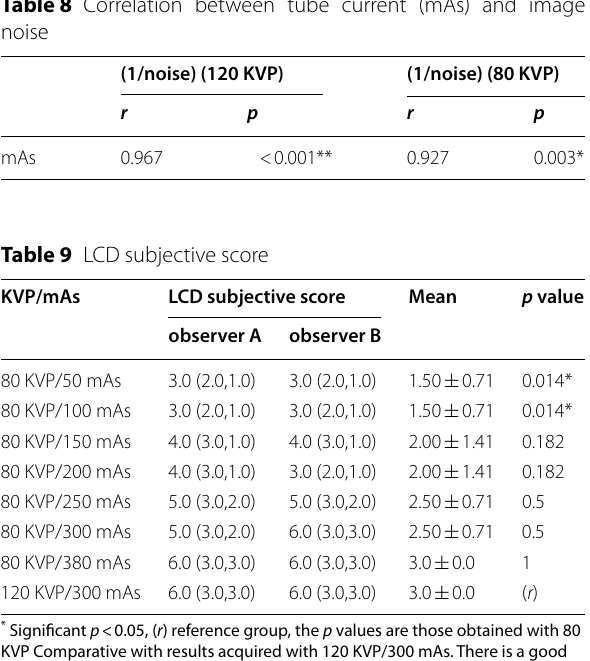
Table 8 Correlation between tube current (mAs) and image